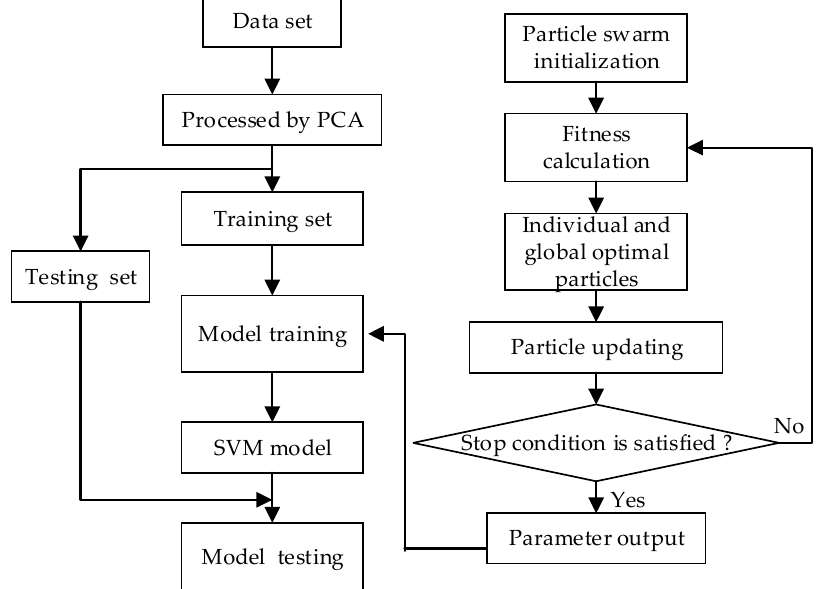
Figure 1. Transformer-fault diagnosis (TFD) model based on support vector machines (SVM) integrated with principal component analysis (PCA) and particle swarm optimization (PSO).